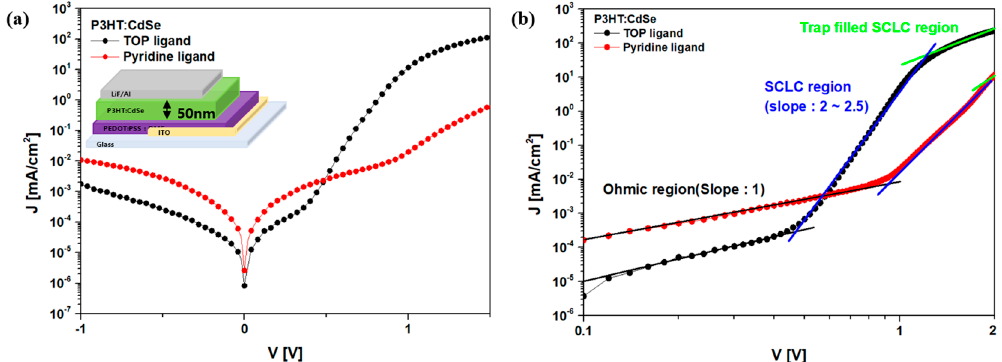
Figure 8. ( a ) J–V characteristics of the detector with P3HT:CdSe QDs = 1:5 active layer measured under dark conditions (TOP and pyridine ligands applied), and ( b ) space charge limited current (SCLC) behavior of the detector with P3HT:CdSe QDs = 1:5 active layer (TOP and pyridine ligands applied). Table 1. Active layer thickness, relative permittivity, and mobility values of the detector with P3HT:CdSe QDs = 1:5 active layer (TOP and pyridine ligands applied).